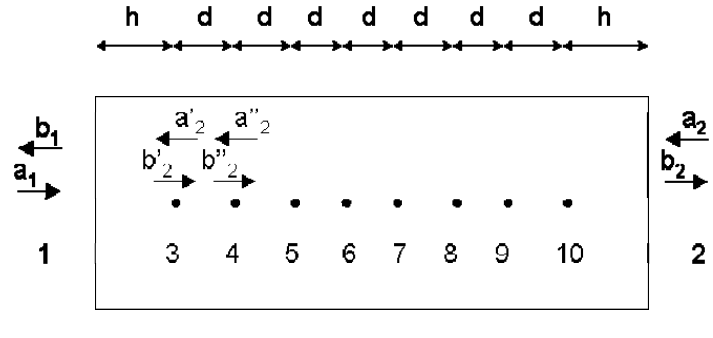
Figure 2. Ten port scheme with input and output ports and sampling coaxial ports, d being the distance between consecutive coaxial probes within the waveguide.